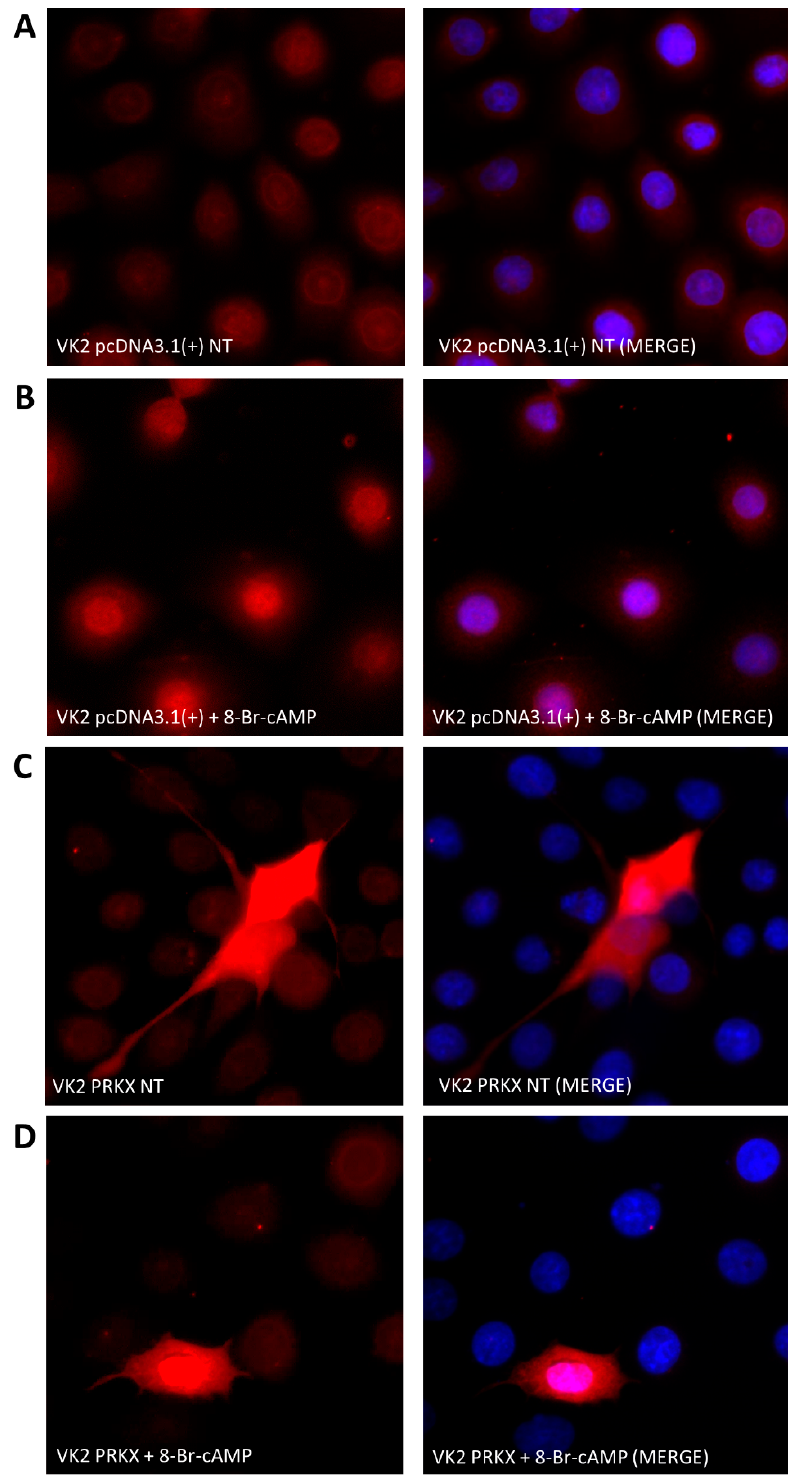
Figure 4. PRKX overexpression and activation in human vaginal keratinocytes. Immunofluorescence showing VK2 E6/E7 transfected with empty vector (pcDNA3.1(+)) in the presence or absence of 8-Br-cAMP ( A , B ) and VK2 E6/E7 transfected with PRKX expression vector (pcDNA3.1(+)-PRKX) with or without 8-Br-cAMP treatment ( C , D ). PRKX is stained with Texas Red, nuclei are stained in blue with DAPI (20× magnification).